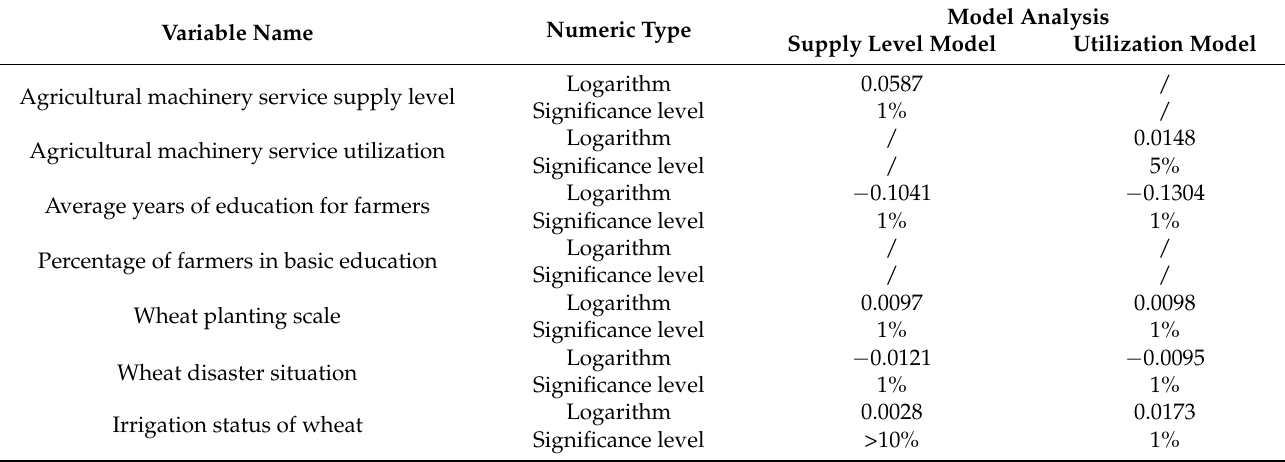
Table 7. Data analysis of wheat